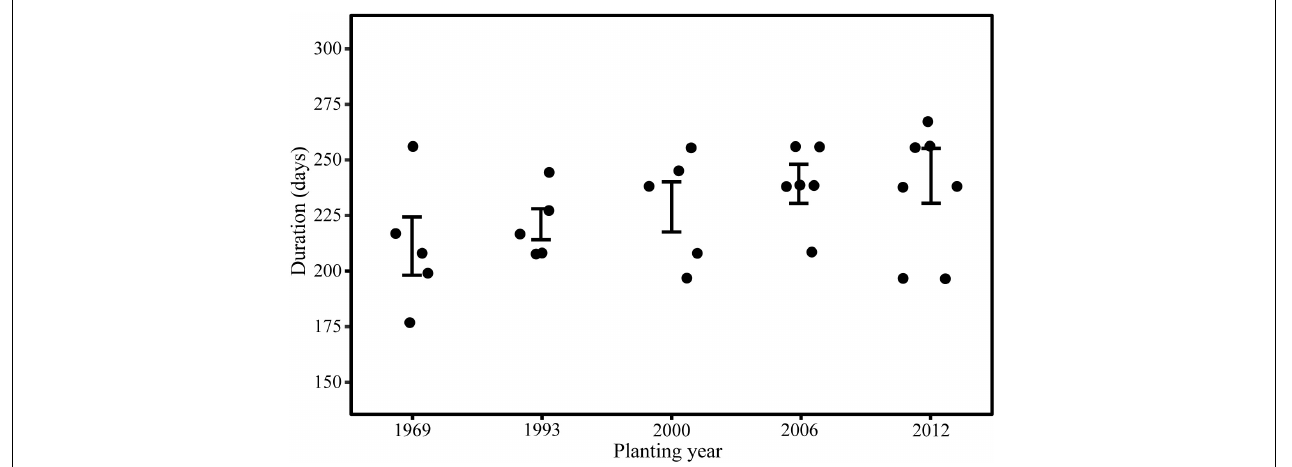
FIGURE 3 | Duration of wood cell development compared between stands of different planting years.